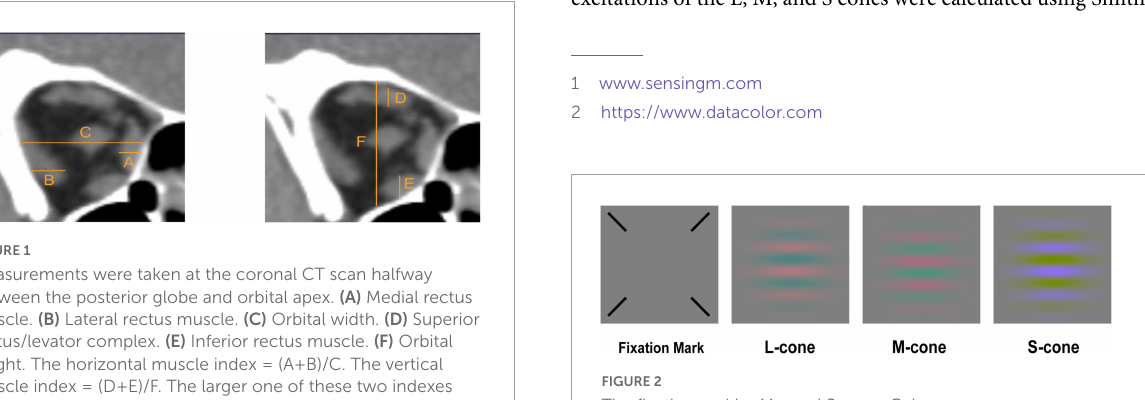
FIGURE2 The fixation and L-, M-, and S-cone